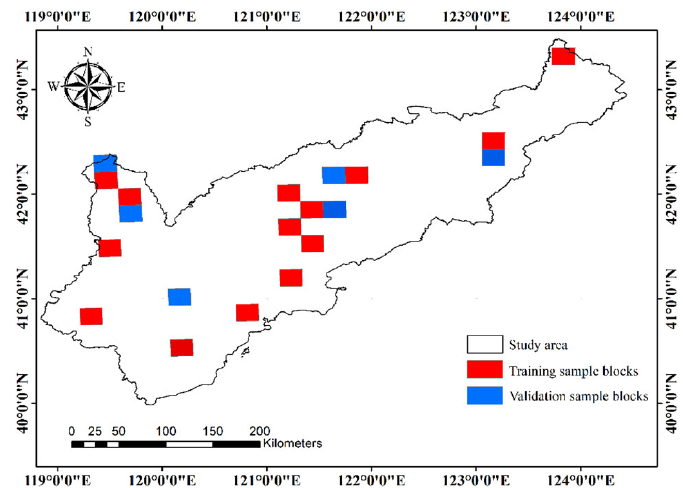
Figure 3. The spatial distribution of the sample blocks. In total, there are 20 blocks in the study area: six blue blocks were used for validation and 14 red blocks were used for training in deep models. The size of each block is 18 km × 18 km.